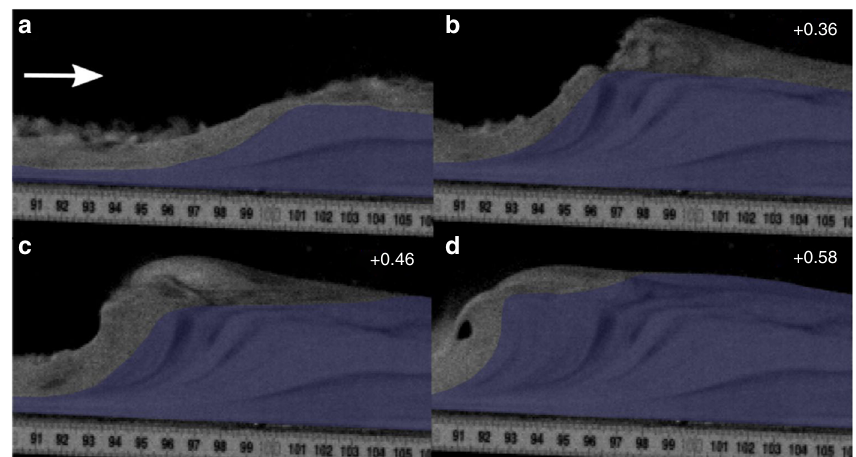
Fig. 7 The formation and evolution of a granular bore. Numbers in the top right are seconds passed since the fi rst frame. Shaded area shows stationary deposit. Flow direction left to right. a shows the initial formation of a steepening bump, with the incoming and outgoing current both supercritical. b shows the upstream propagation and further steepening of the bore, immediately after blocking of the outgoing current. c The bore propagates further upstream, the front steepening to vertical. d The front of the bore collapses upstream by